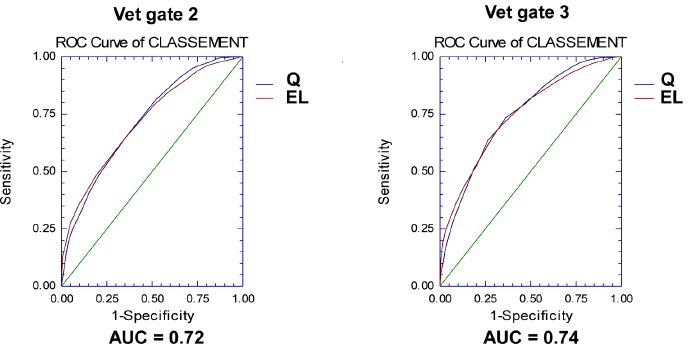
Fig 3. ROC curves of the logistic regressions for vet gates 2 and 3. The AUROC values (0.72 and 0.74, respectively) were acceptable and were associated with correct classification rates of 64% and 68%, respectively (AUROC = area under the ROC curve, Q = qualified, EL = eliminated).